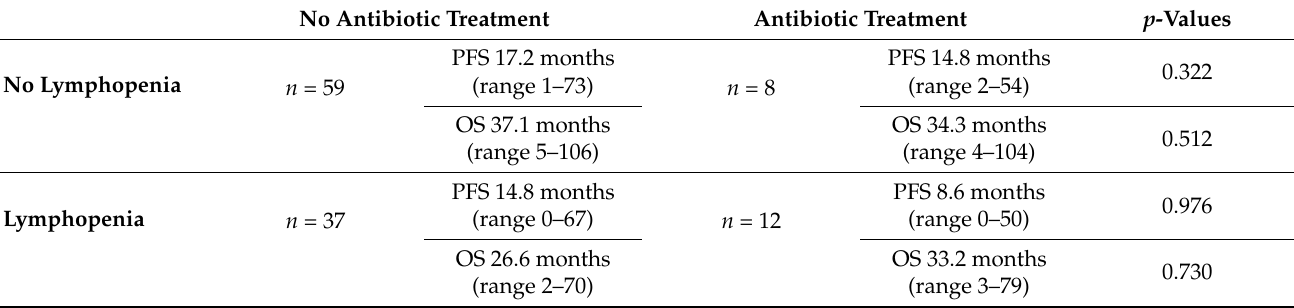
Table 3. PFS and OS, depending on antibiotic treatment and development of lymphopenia during ICI therapy. PFS and OS were compared between the different